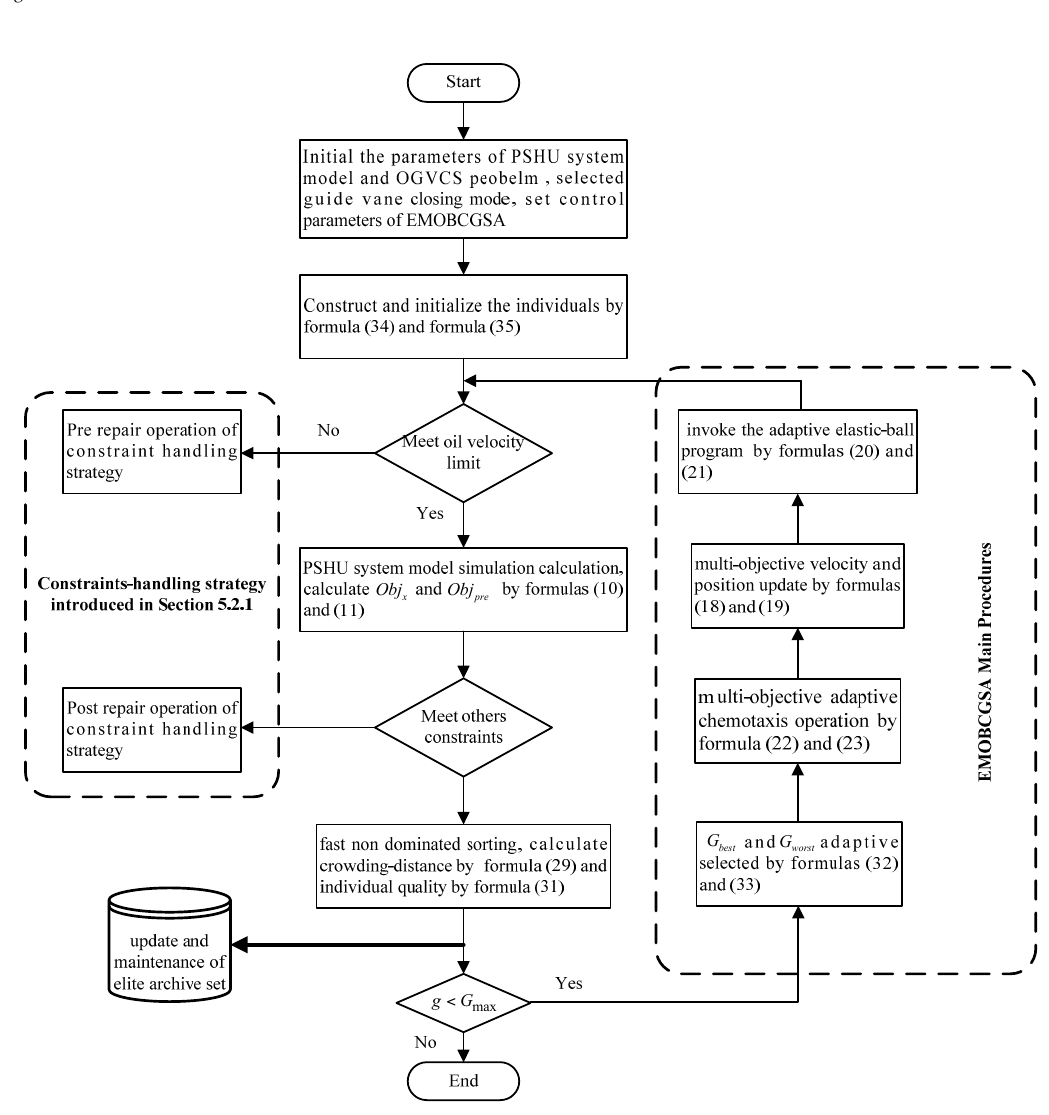
Figure 7. The flowchart of EMOBCGSA for solving OGVCS problem.